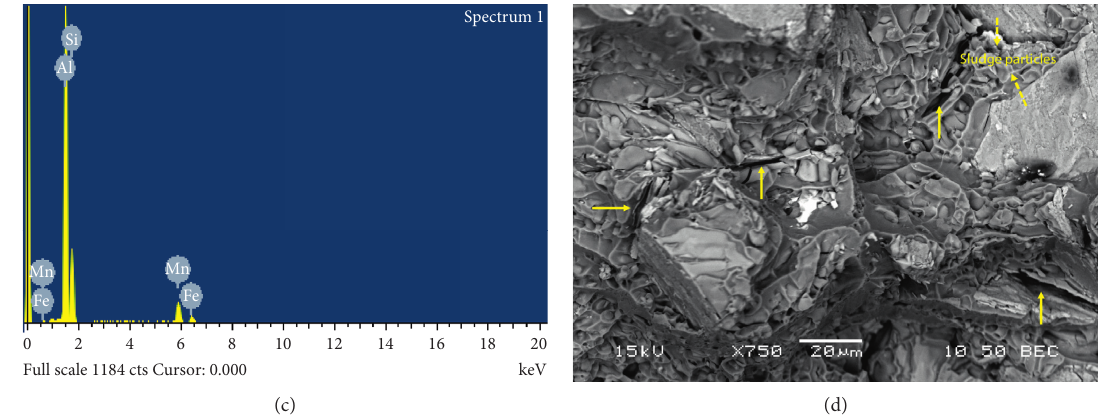
Figure 9: SEM images of T6-treated M3S alloy after stabilization at 250 ° C for 1 hour: (a) BSE image showing a branched crack in a Q -phase particle and sludge particles preventing crack propagation, (b), (c) EDS spectra corresponding to the Q -phase and the sludge particle observed in (a), and (d) BSE image showing various cracked intermetallic phases and crack-free sludge particles.